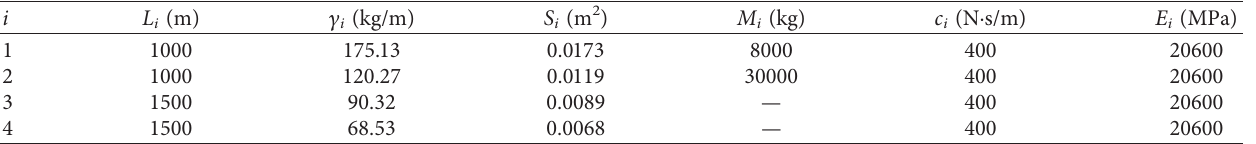
Table 2: Relevant physical parameters of the lifting pipe